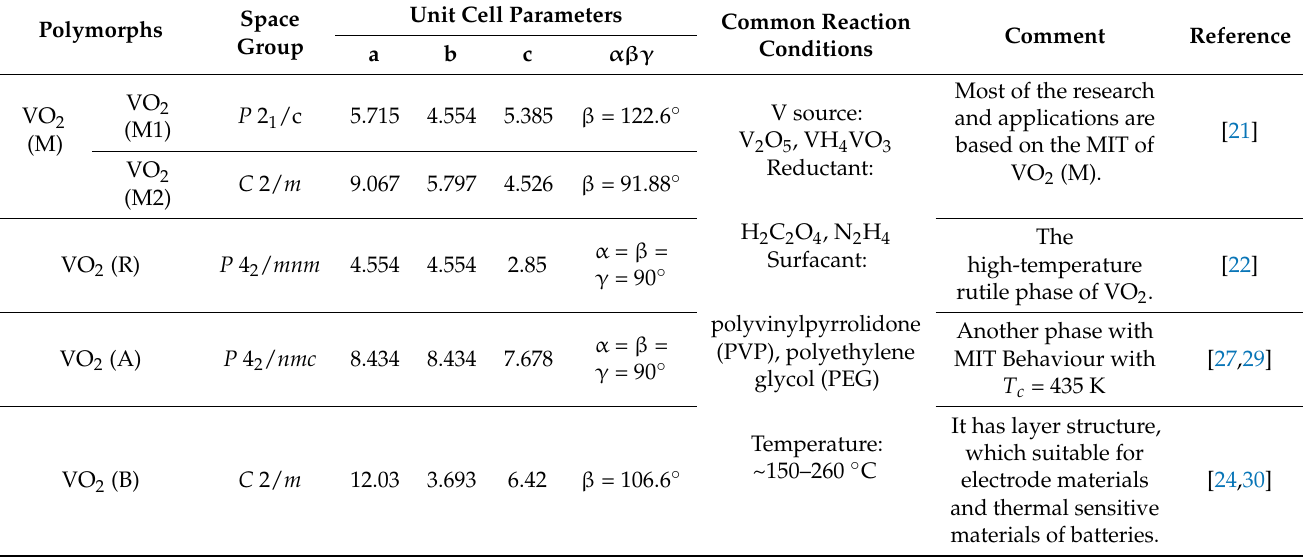
Comment Reference Conditions